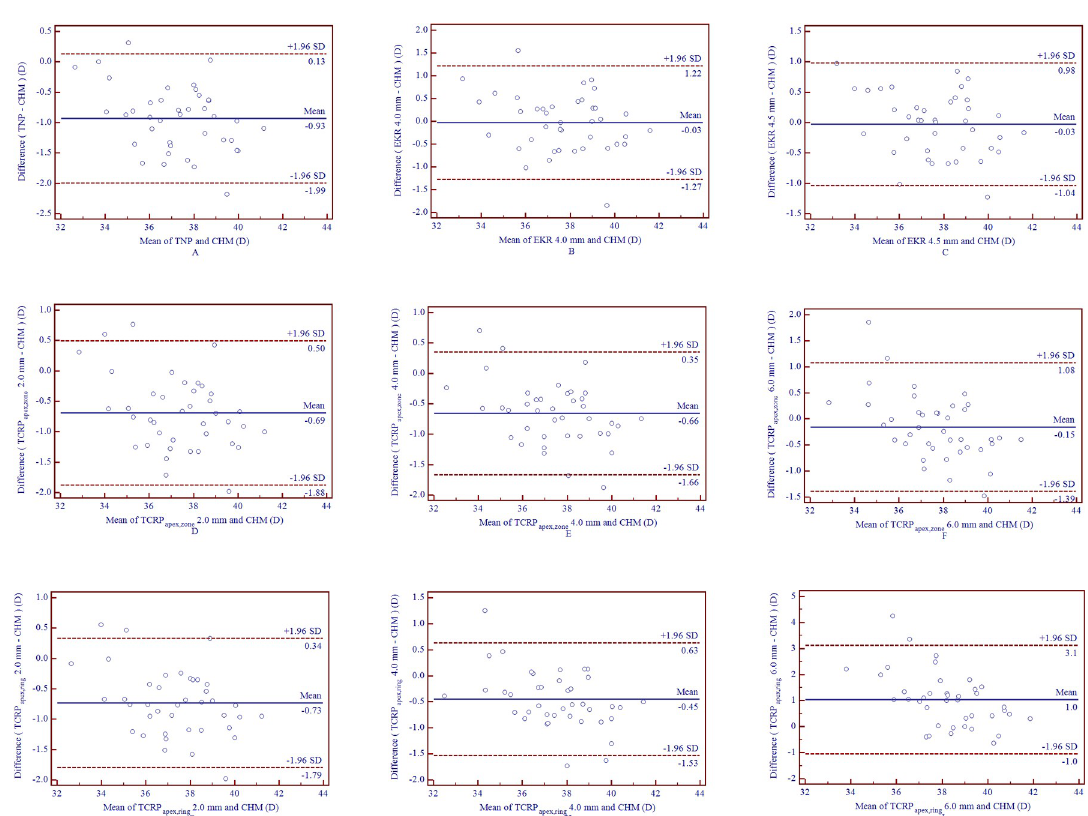
Fig 2. Bland-Altman plots of agreement of various corneal power measurements (TNP, EKRs and a series of apex-centered TCRP) compared with the CHM value in eyes following SMILE surgery (A-I represent TNP, EKR 4.0 mm, EKR 4.5 mm, 2.0 mm, 4.0 mm and 6.0 mm TCRP apex,zone , 2.0 mm, 4.0 mm and 6.0 mm TCRP apex,ring , respectively). The solid line represents the mean difference (bias). The upper and lower lines represent the 95% LOA (the 95% LOA are shown with the dashed lines.) (CHM = clinical history method; EKR = equivalent keratometry readings; LOA = limits of agreement; SMILE = small incision lenticule extraction; TCRP = total corneal refractive power; TCRP apex,zone /TCRP apex,ring represent TCRP within a diameter of a zone or ring centered on the corneal apex; TNP = true net